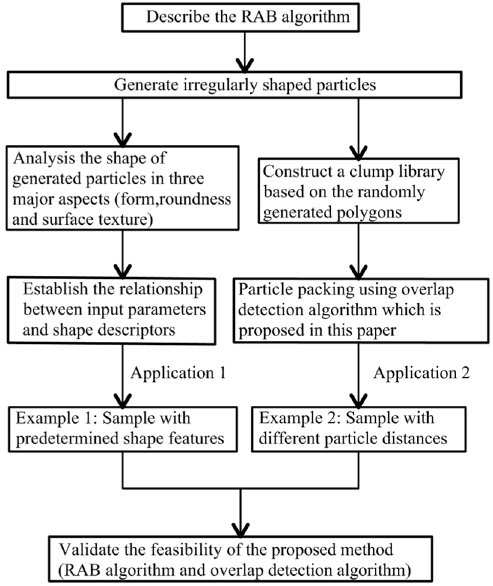
Figure 1. Flowchart of this paper.